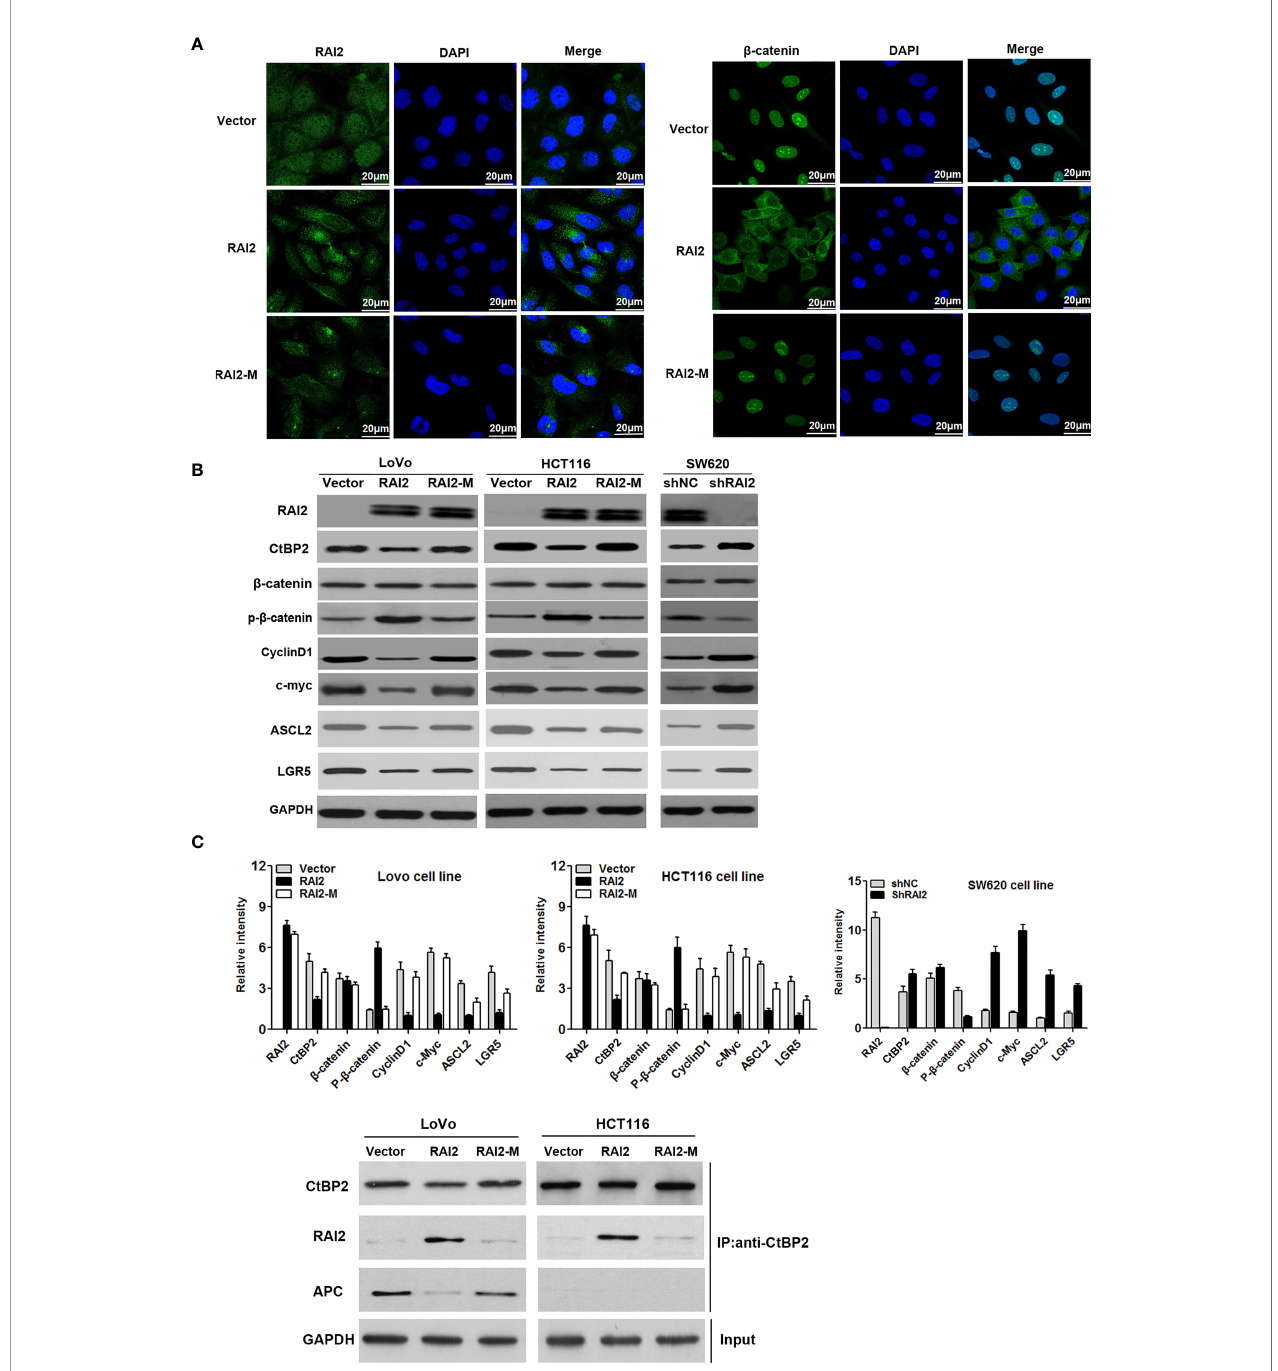
FIGURE 3 | RAI2 inhibits the nuclear translocation of b -catenin and suppresses the expression of Wnt signaling target genes. (A) Immuno fl uorescence analysis of expression and localization of RAI2 and b -catenin in LoVo cells with empty vector/RAI2/RAI2-M (mutant type RAI2 plasmid) transfection. The left panel showed the expression and localization of RAI2 in LoVo cells before and after RAI2/RAI2-M transfection; the right panel showed the expression and localization of b -catenin in LoVo cells before and after RAI2/RAI2-M transfection. (B) Western blot analysis of RAI2, b -catenin, phosphorylated b -catenin (p- b -catenin), CtBP2, and the Wnt/ b - catenin signaling target genes c-Myc, CylinD1, ASCL2, and LGR5 expression in LoVo/HCT116 cells with empty vector/RAI2/RAI2-M (mutant type RAI2 plasmid) transfection and SW620 cells with shNC/shRAI2 transfection. (C) Coimmunoprecipitation (Co-IP) analysis of CtBP2 and APC interaction by anti-CtBP2 antibody using cell lysates from LoVo and HCT116 cells transfected with vector, RAI2 expression vector or mutant type RAI2 vector (RAI2-M). Extracted cell lysates of LoVo and HCT116 cells before adding antibodies were used for GAPDH detection